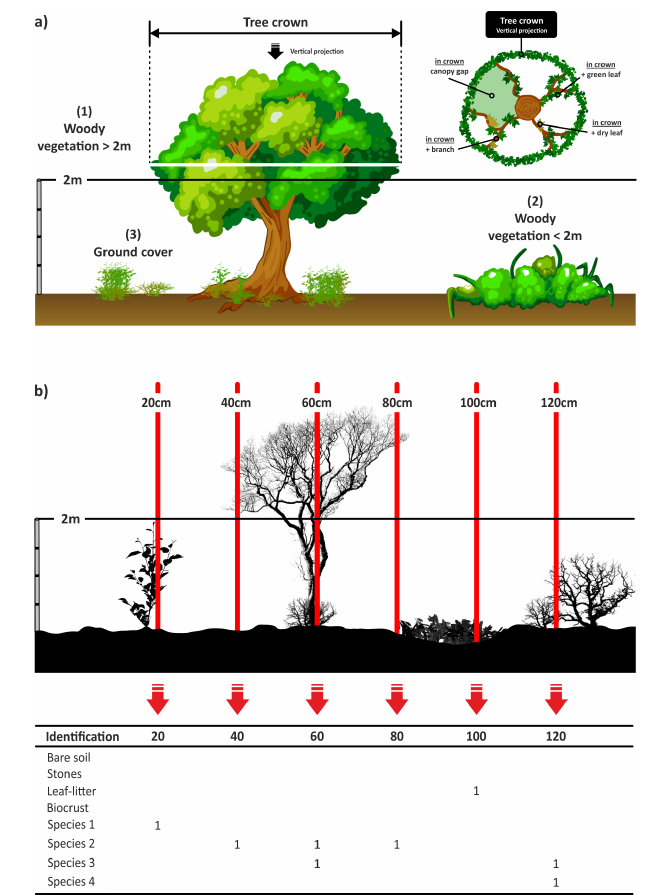
Figure 9. (a) Examples of the three categories of vegetation mea- sured (redrawn from Muir et al., 2011). (b) Example of an annotated transect. Each intercept is recorded with